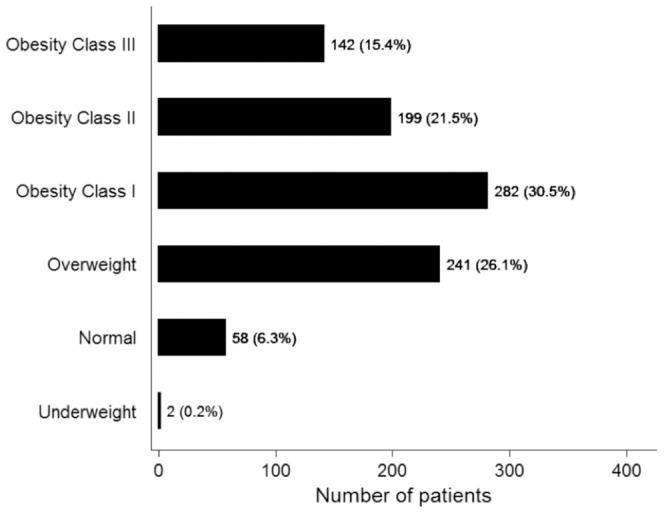
Initial body mass index (BMI) distribution of 924 non-cirrhotic NAFLD patients.Baseline BMI was stratified using the following definitions: underweight (<18.5 kg/m2), normal weight (18.5–24.99 kg/m2), overweight (25.0–29.99 kg/m2), class I obesity (30.0–34.99 kg/m2), class II obesity (35.0–39.99 kg/m2), and class III obesity (≥40 kg/m2).